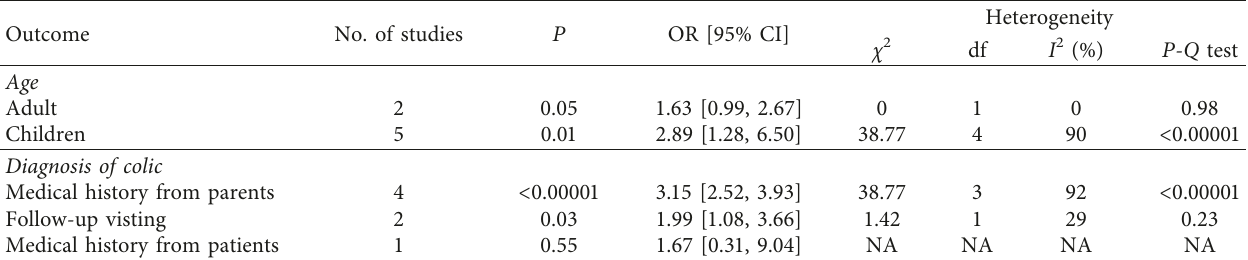
Table 3: Meta-analysis based on age and diagnosis of